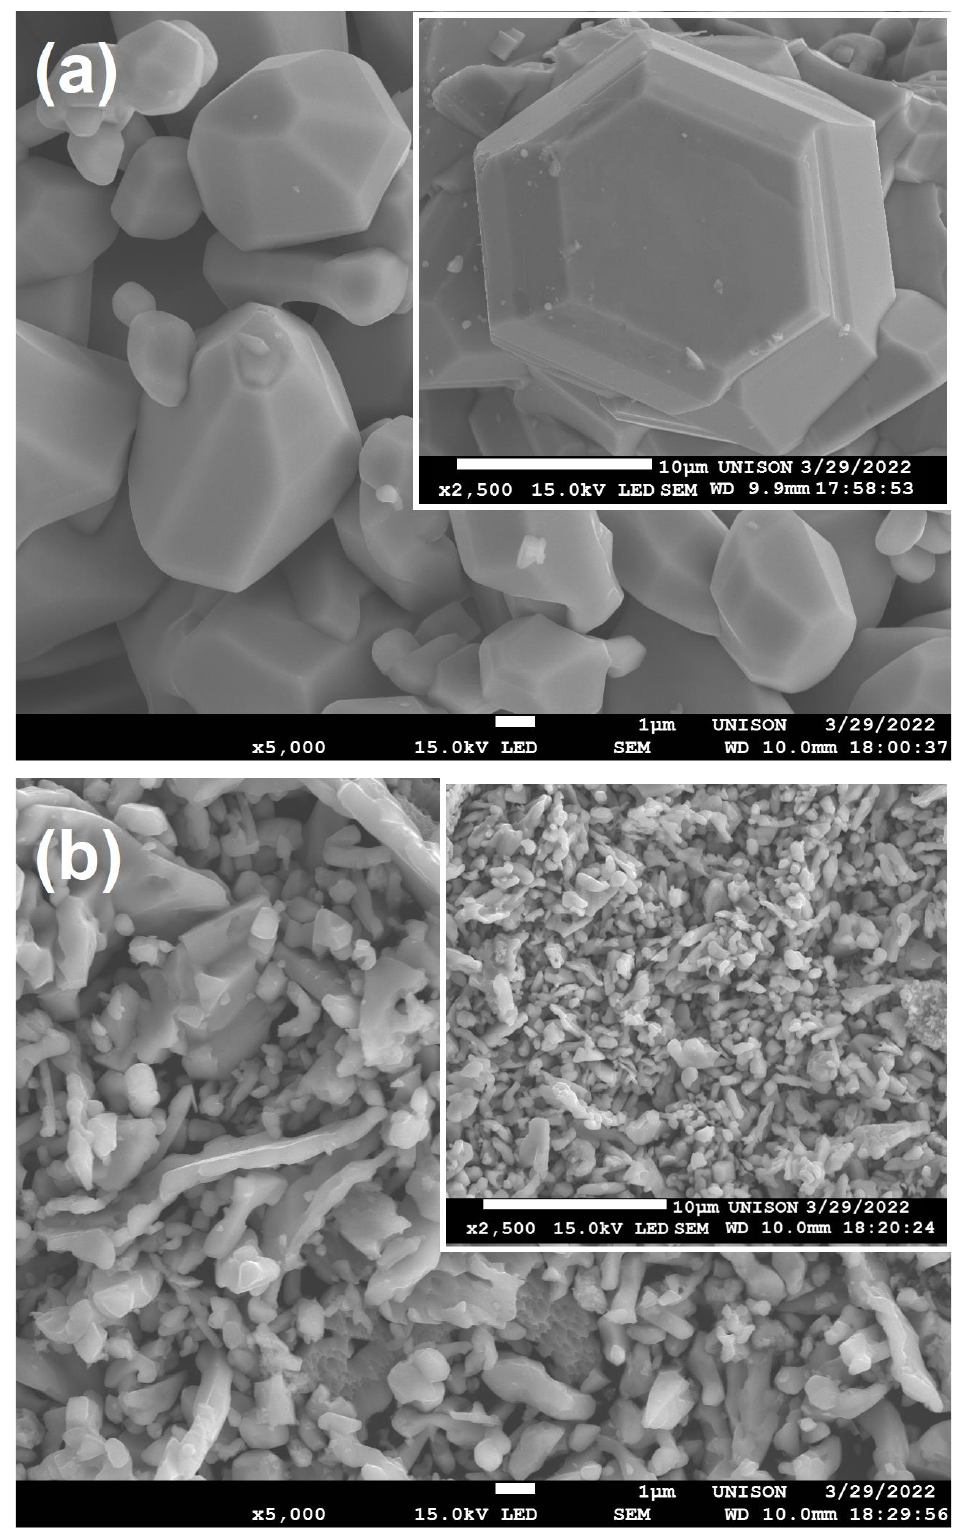
Figure 3. ( a ) SEM micrographs of the undoped GaN powders; ( b ) SEM micrographs of the Mg-Zn co-doped GaN powders.